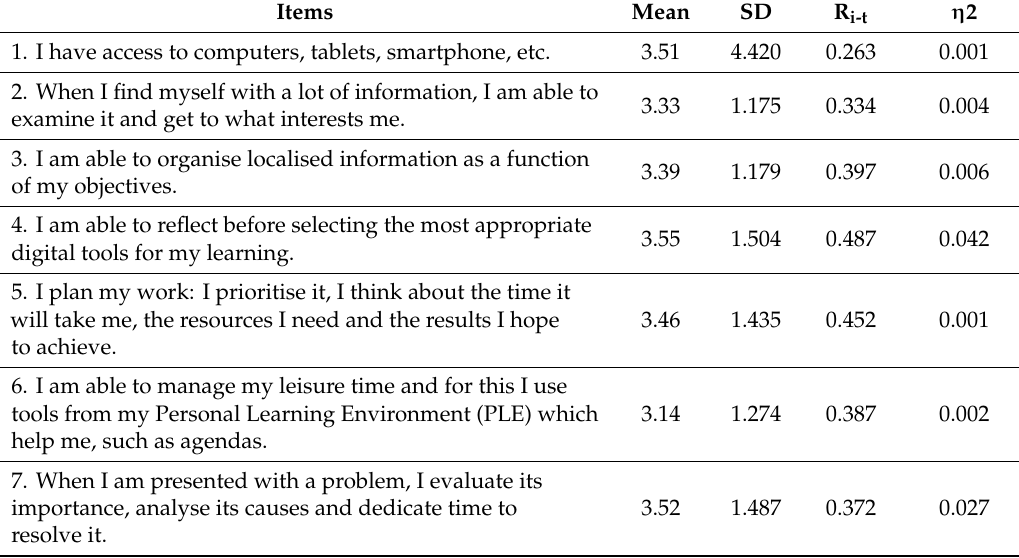
Table A1. Mean, standard deviation and discrimination index obtained after administration of the socio-educational integration strategies questionnaire